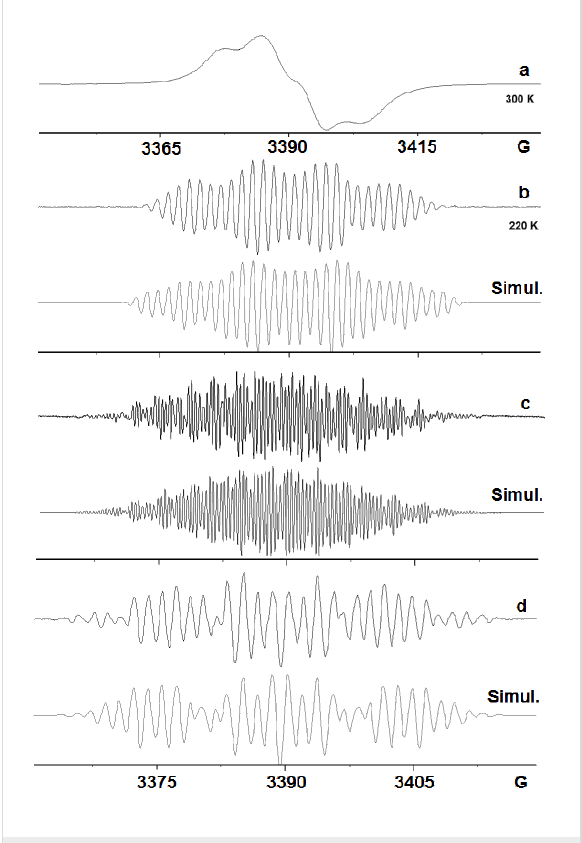
Figure 1: EPR spectra after treatment of azide 2 with MCl 3 . (a) AlCl 3 in DCM; 1st derivative spectrum at 300 K. (b) AlCl 3 in DCM; 2nd derivative spectrum at 220 K; below: computer simulation with the parameters listed in Table 1. (c) GaCl 3 in DCM/pentane at 300 K with the computer simulation below. (d) InCl 3 in DCM:CH 3 CN; 4:1 at 320 K; computer simulation below.